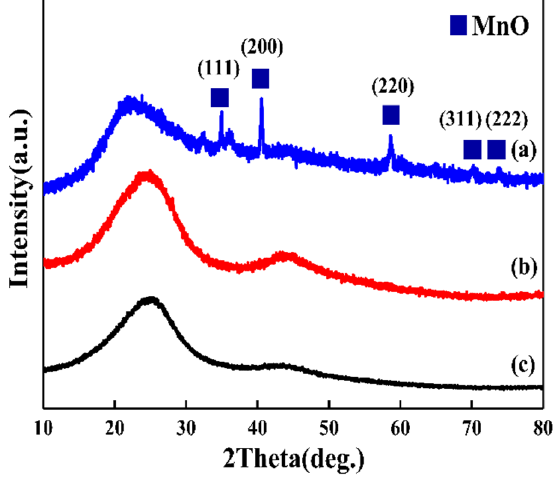
Figure 5. X‐ray diffraction (XRD) patterns of the Mn embedded‐carbon nanofibers ( a ) CN, ( b ) CN‐Mn1 and ( c ) CN‐Mn2.